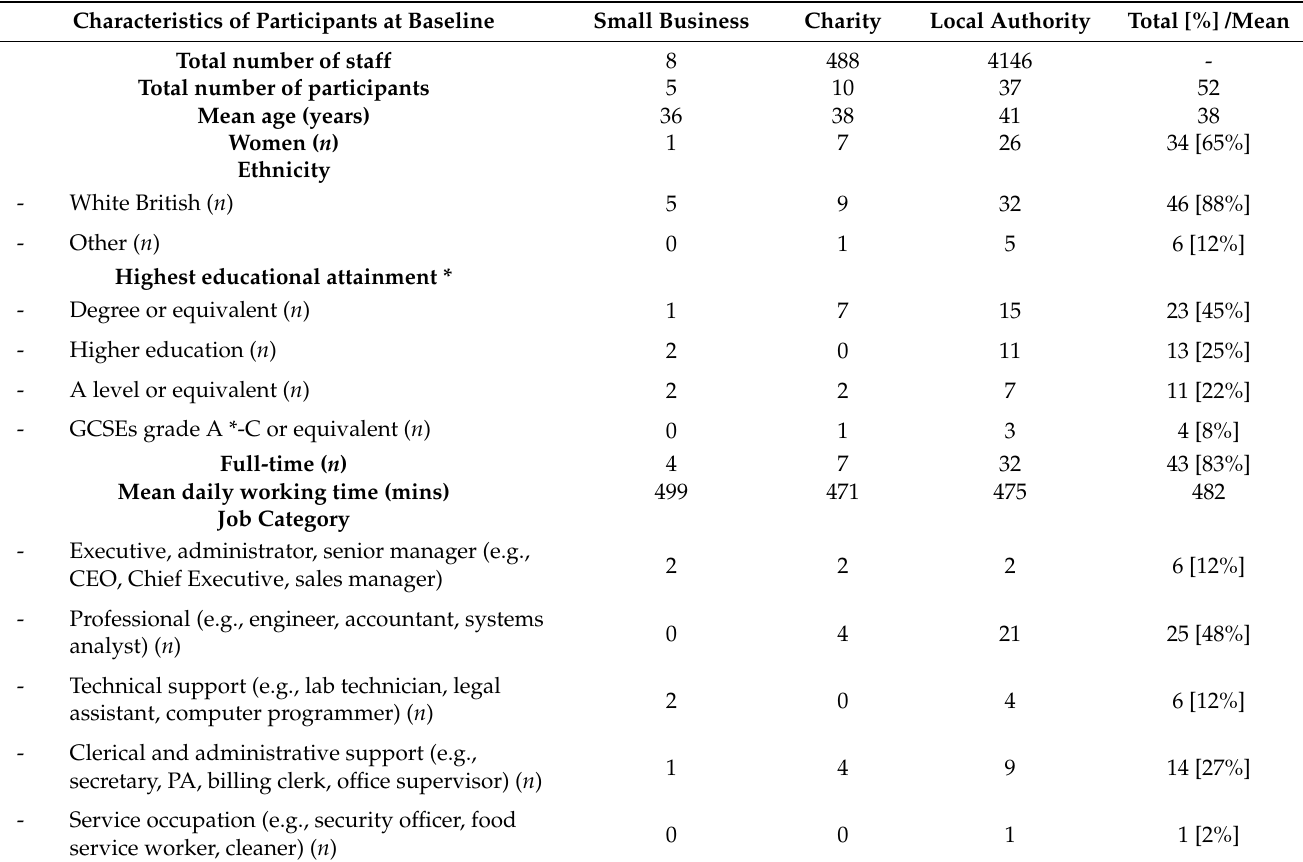
Table 2. Participant characteristics (those who wore activPAL3™ devices at